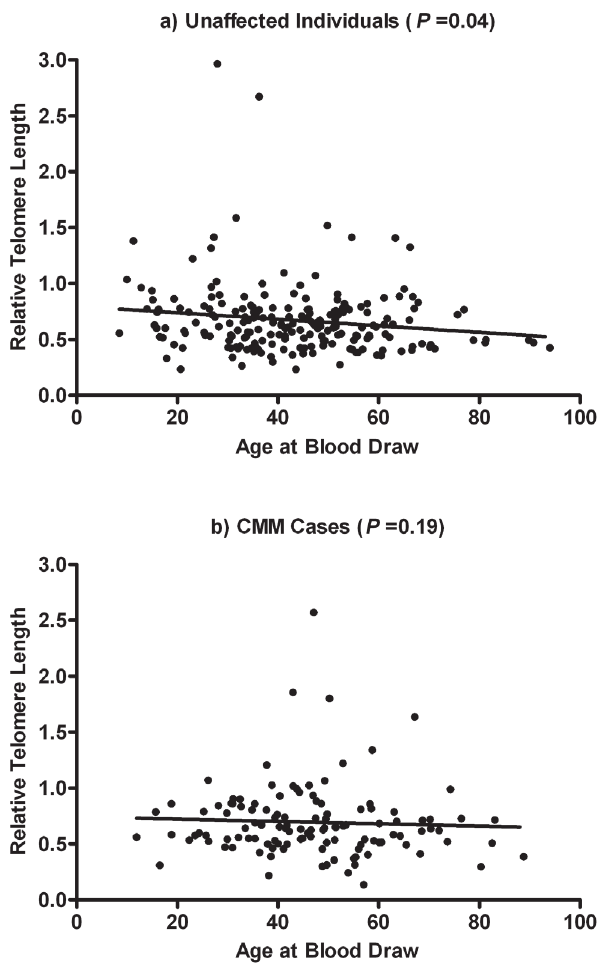
Figure 1. Correlations between relative telomere length and age at blood draw in unaffected individuals and CMM cases. P values were obtained from the Spearman correlation test.